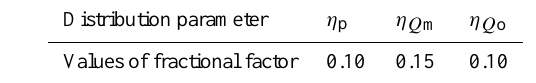
Table 3. Fractional factors used to perturb the precipitation ( η p ), simulated streamflow ( η Q m ) and the observed streamflow ( η Q o